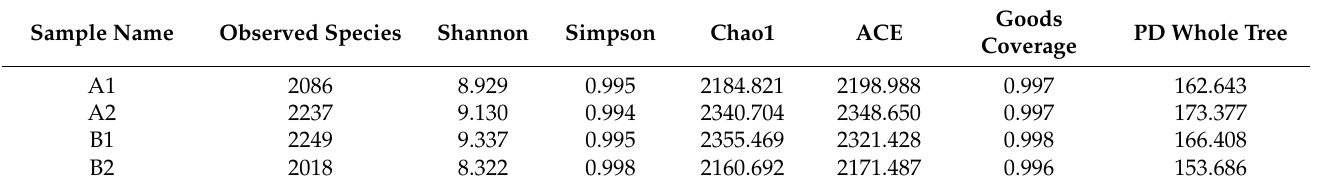
Table 3. Alpha diversity indices (A1 TH, thermophilic of Harmanli site; A2 MH, mesophilic of Harmanli site; B1 M_YP, mesophilic of Yasno pole site; B2 T_YP, thermophilic of Yasno pole site).